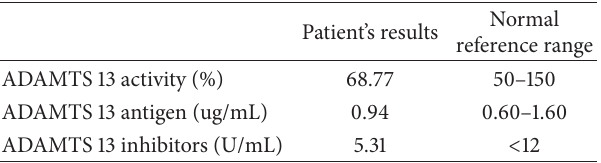
Table 1: Results of ADAMTS 13